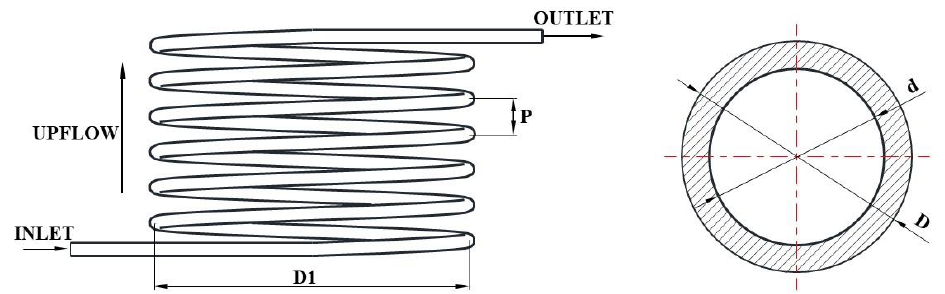
Figure 5. Schematic of spiral tube geometry model.